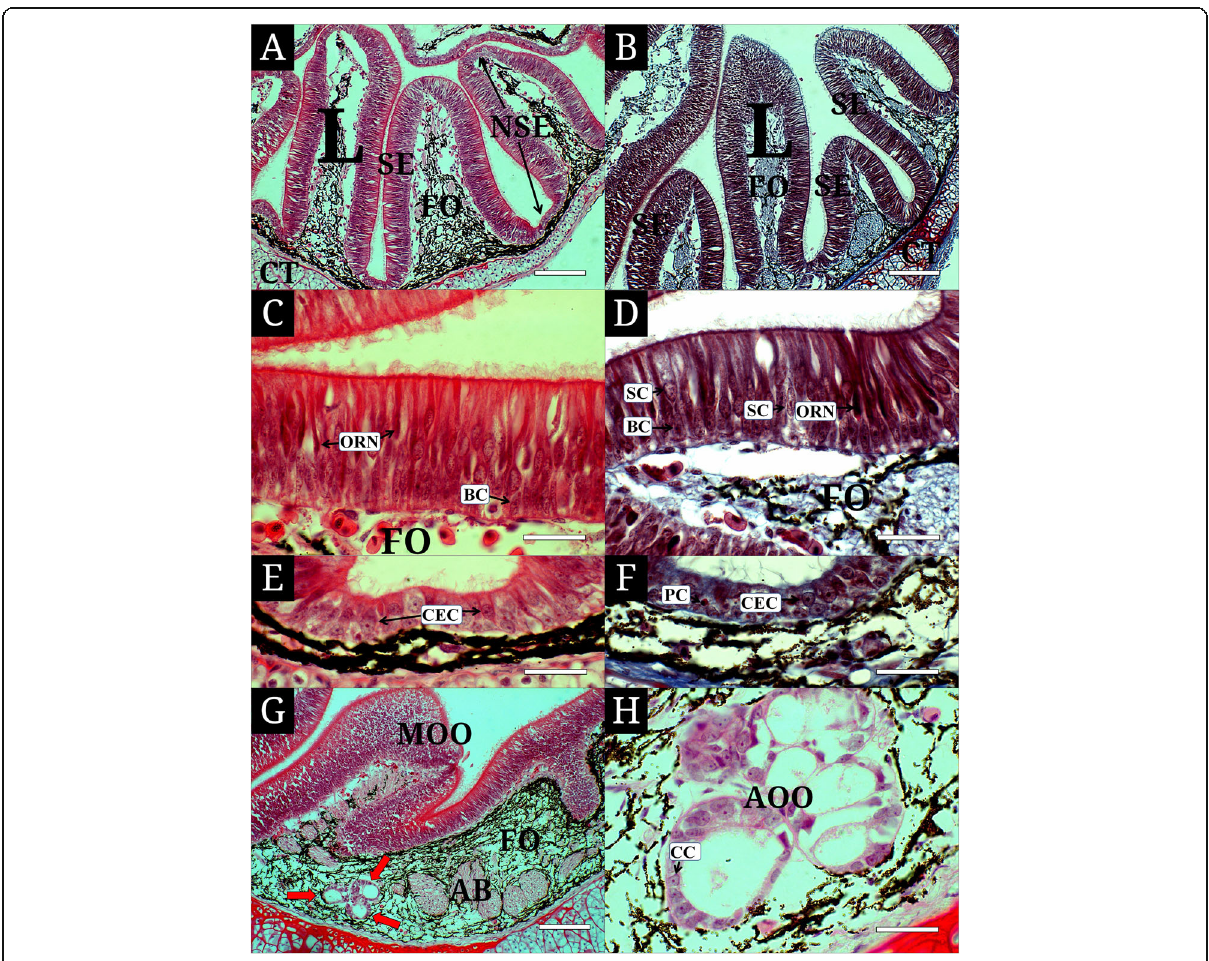
Fig. 3 Histological characteristics of the olfactory epithelium of Lethenteron reissneri , stained with hematoxylin and eosin ( a, c, e, g ) and Masson ’ s trichrome. a, b ), the main olfactory epithelium consisting of the sensory and non-sensory epithelium; c, d ), the sensory epithelium with olfactory receptor neurons, supporting cells and basal cells; e, f ), the non-sensory epithelium having columnar epithelial cells and plasma cells; g, h ), the accessory olfactory organ with olfactory receptor neurons. AOO, accessory olfactory organ; BC, basal cell; CC, cuboidal epithelial cell; CEC, columnar epithelial cell; CT, cartilaginous tissue; FO, fila olfactoria; L, lamellae; MOE, main olfactory epithelium; NSE, non-sensory epithelium; ORN, olfactory receptor neuron; PC, plasma cell; red arrow; accessory olfactory organ; SC, supporting cell; SE, sensory epithelium. Bars indicate 200 μ m in a, b, g and 50 μ m in c, d, e, f, h ,